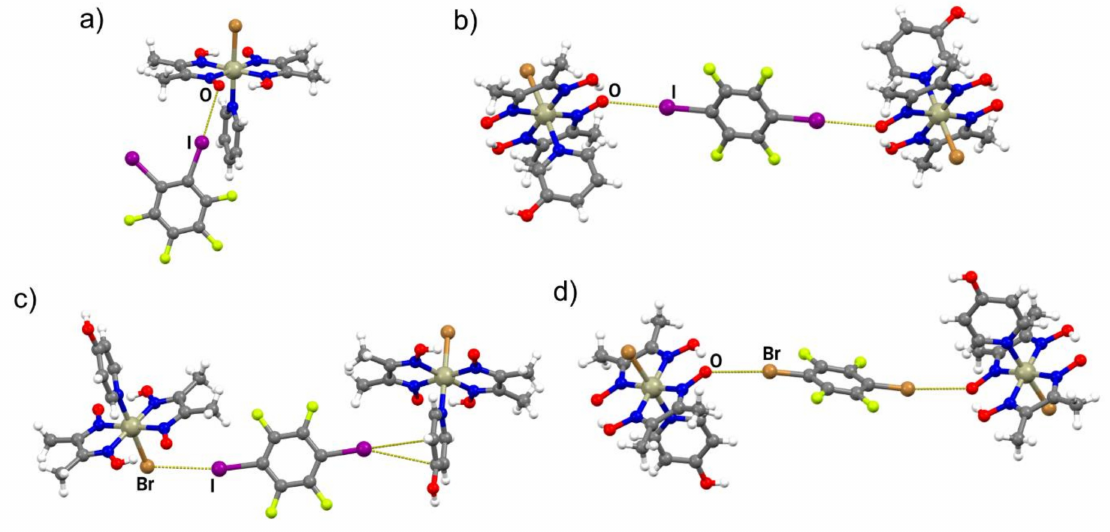
Figure 2. Discrete halogen-bonded units in ( a ) ( I )( 12tfib ); ( b ) ( II ) 2 ( 14tfib ); ( c ) ( III ) 2 ( 14tfib ); ( d ) ( III) 2 ( 14tfbb